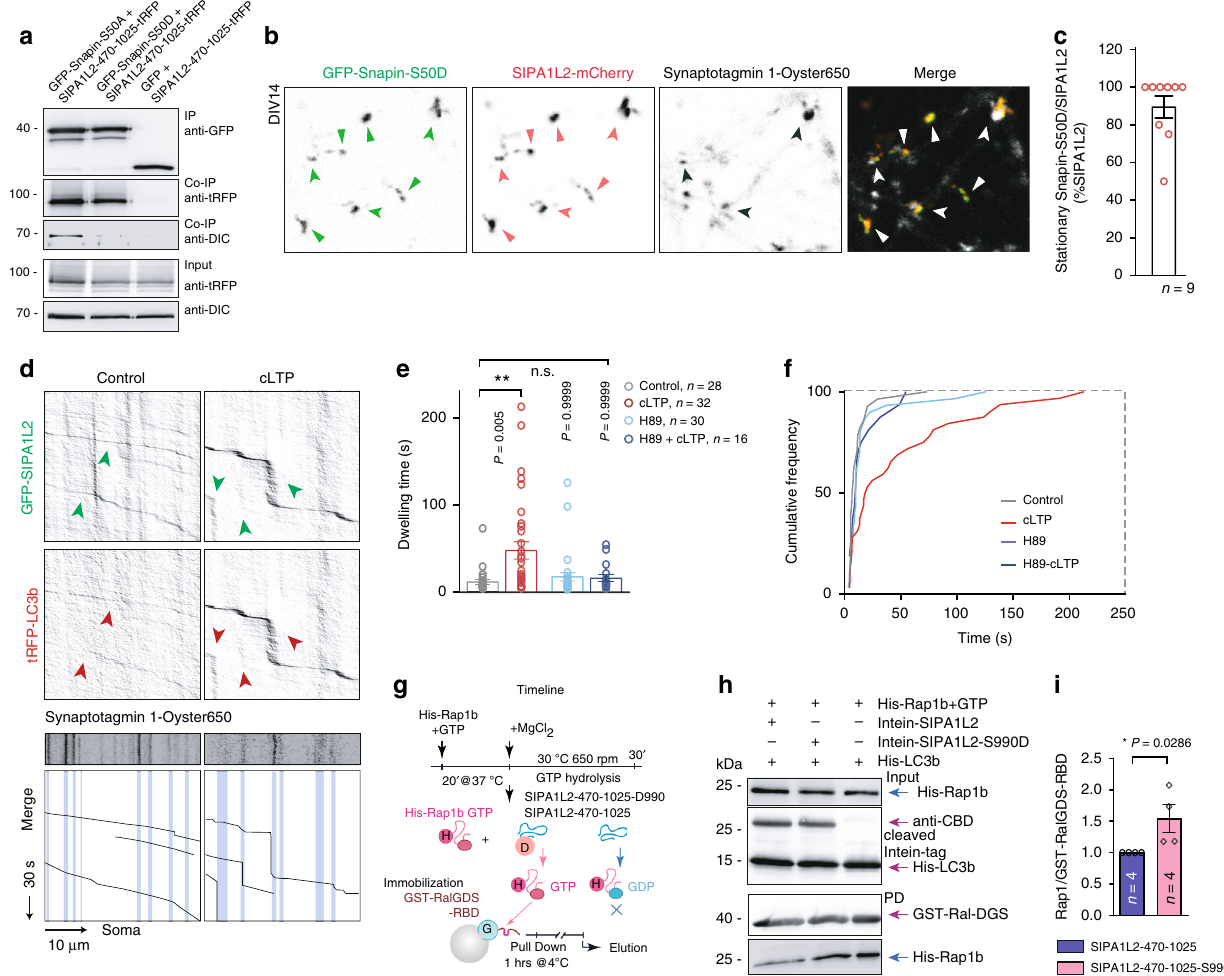
Fig. 6 cLTP prolongs dwelling time of SIPA1L2-amphisomes at presynaptic boutons. a Heterologous coimmunoprecipitation experiments using SIPA1L2- 470-1025-tRFP (RapGAP-PDZ) and a phospho-de fi cient (GFP-Snapin-S50A) or a phosphomimetic Snapin mutant (GFP-Snapin-S50D). Both forms of Snapin coimmunoprecipitates with SIPA1L2, but only the phospho-de fi cient form of Snapin coimmunoprecipitates with DIC. b , c Snapshots in b obtained from time-lapse imaging in rat hippocampal cells overexpressing GFP-Snapin-S50D together with fl -SIPA1L2-mCherry where mostly immobile ( b , arrows) vesicles were found at presynaptic terminals labeled with anti-Synaptotagmin 1-Oyster650 (black arrows). Scale bar is 10 μ m. In c quanti fi cation of the percentage of stationary cotrajectories (note the difference with Fig. 3k). d – f Kymographs generated from axons coexpressing GFP-SIPA1L2 and tRFP-LC3b and labeled in vivo with Stgm-1 Oyster650 after control or chemical long-term potentiation (cLTP) induction. Imaging was performed in nonconditioned, extracellular imaging buffer. Below, merge images represent traces of cotrajectories aligned with positions of presynaptic boutons (shaded blue lines). Dwelling time of the SIPA1L2-LC3b-amphisomes at boutons is represented in e and corresponding cumulative distribution diagram in f . Data represented as mean ± SEM. N numbers in e , f correspond to vesicles analyzed from 11 axons (control), 14 axons (cLTP), 8 axons (H89) and 6 axons (H89 + cLTP) (one-way ANOVA on ranks with Dunn ’ s multiple comparison test for vesicles). g – i In g , the timeline for the RapGAP activity assays performed in h , i . Recombinant intein-tagged SIPA1L2-470-1025 as well as SIPA1L2-470-1025-S990D (phosphomimetic SIPA1L2 mutant in a potential PKA phosphosite) were used to hydrolize recombinant Rap1b loaded with GTP in the presence of LC3b. Quanti fi cation of four independents experiments in i (Mann-Whitney U test). Bar graphs depict data as mean ± SEM. "*" indicates P ≤ 0.05; "***" indicates P ≤